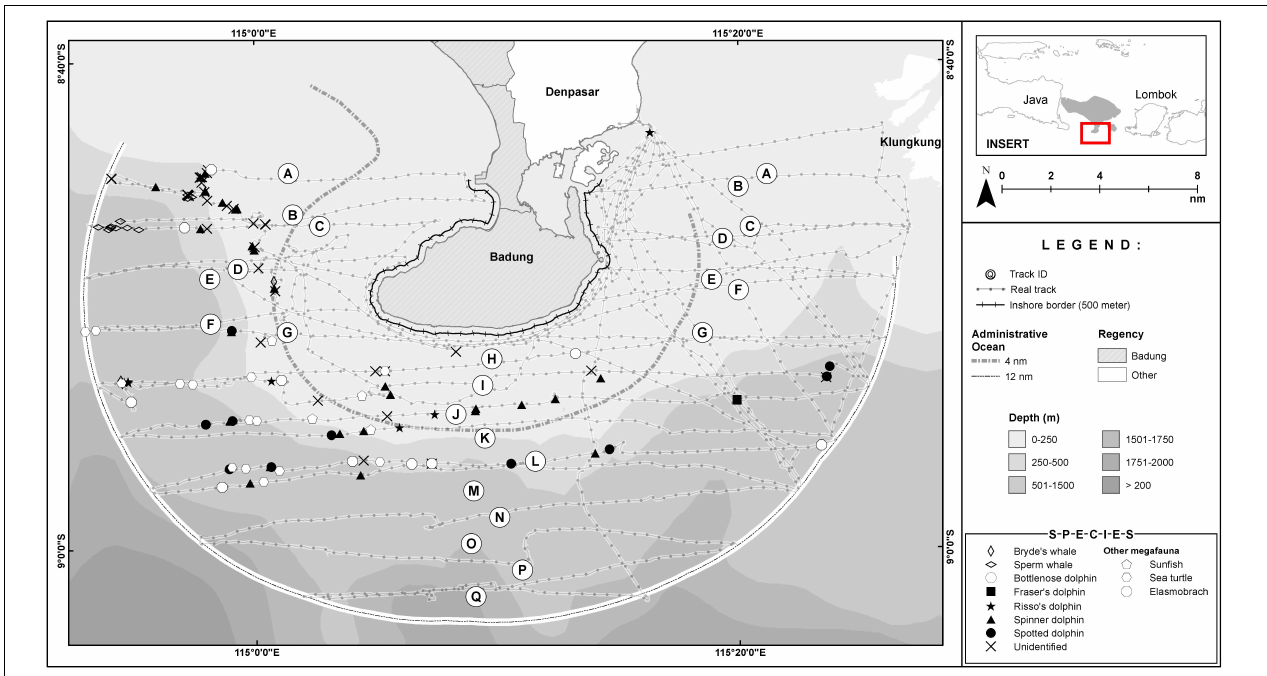
FIGURE 4 | Survey tracks undertaken 30 October to 5 November 2015 during the line transect survey of Bukit Peninsula and dolphins, whales, and other megafauna species recorded within 12 nautical miles (22.2 km) of the Bukit Peninsula. Sightings are plotted over bathymetry data: darker shades indicate increased depth (m). Lines N, O, P, and Q experienced missing data due to a technical